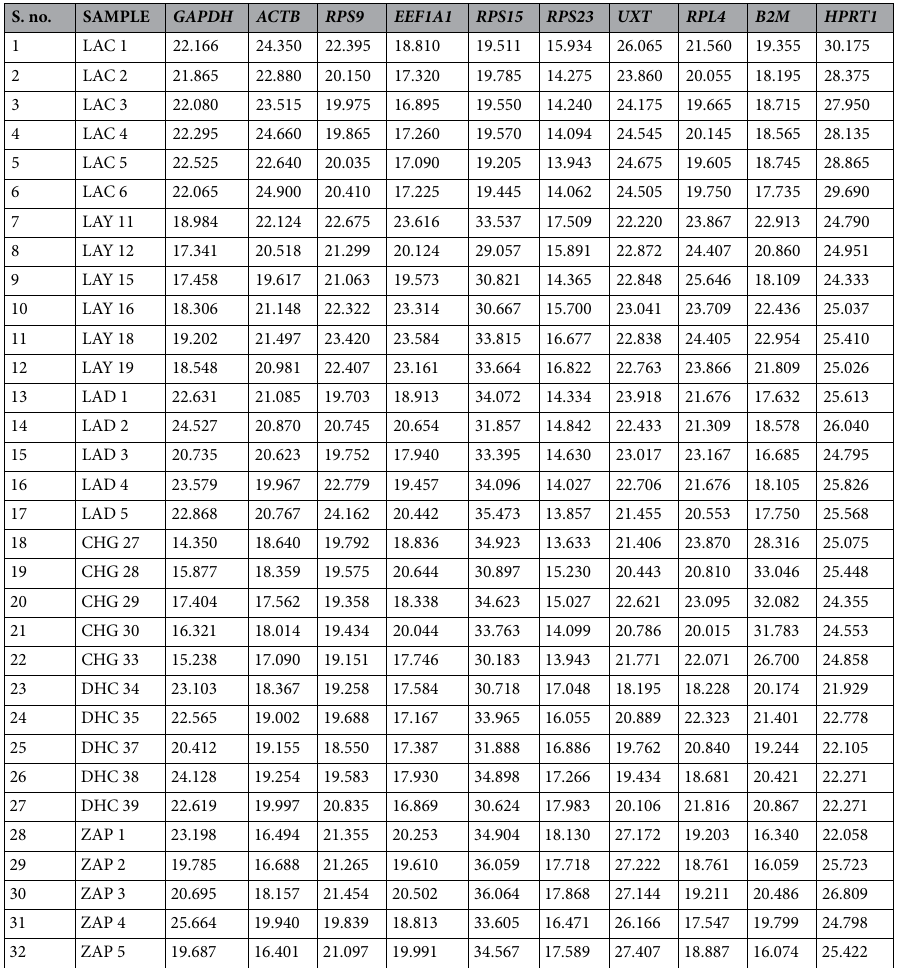
Table 2. The average raw Ct values of individual RGs in different